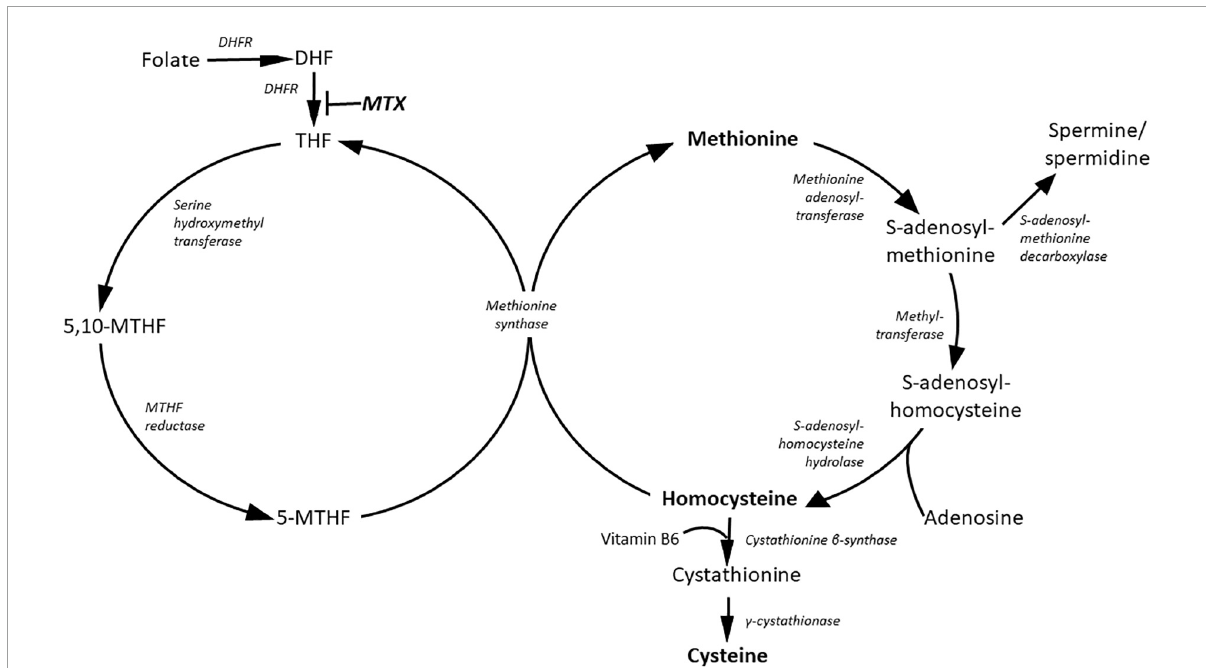
FIGURE2 Metabolites of the methionine and folate cycles. DHF, dihydrofolate; DHFR, dihydrofolate reductase; MTHF, methylene-tetradhydrofolate; MTX, methotrexate; THF,